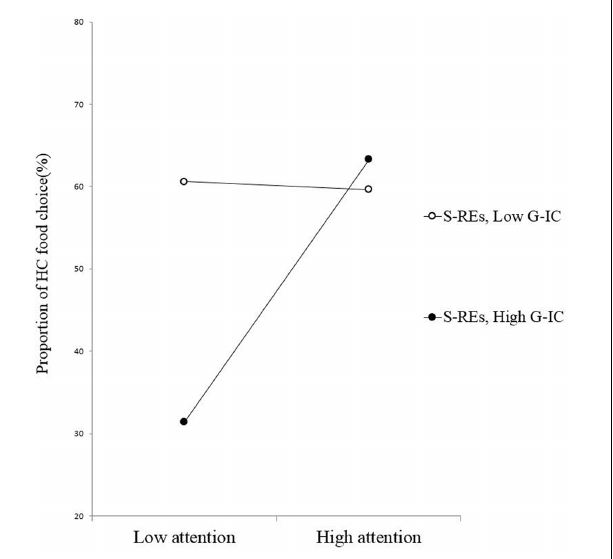
FIGURE 2 | Slopes for the automatic attention–food choice relationship across levels of G-IC among the S-REs.